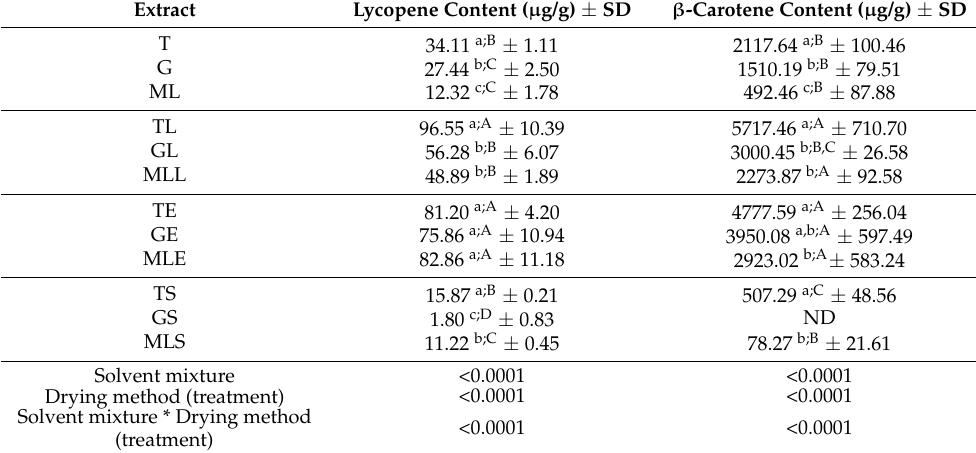
Table 2. Carotenoid content in the extract obtained with the three different solvent solutions in combination with the three drying methods. The samples were named using the combination of codes, identifying the different solvent solution, acetone: n -hexane (1:1 % v / v ) (T), ethyl acetate:ethyl lactate (30:70 % v / v ) (G), and DL-menthol:lactic acid (8:1 mol/mol) (ML), and the three drying techniques, freeze-drying (L), non-thermal air-drying (E), and heat drying (S) (e.g., MLL: extract obtained from the use of DL-menthol:lactic acid from the freeze-dried by-product). Extract Lycopene Content ( µ g/g) ± SD β -Carotene Content ( µ g/g) ± SD T 34.11 a;B ± 1.11 2117.64 a;B ± 100.46 G